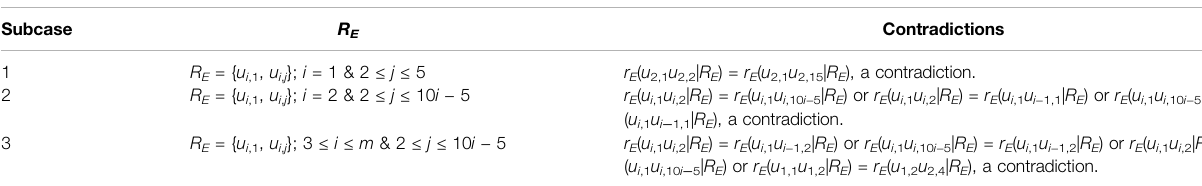
TABLE 1 | Case 1: When both of the vertices u l,1 , u z,j lie on the same i th -cycle i.e., l (cid:1) z (cid:1) i Subcase R E